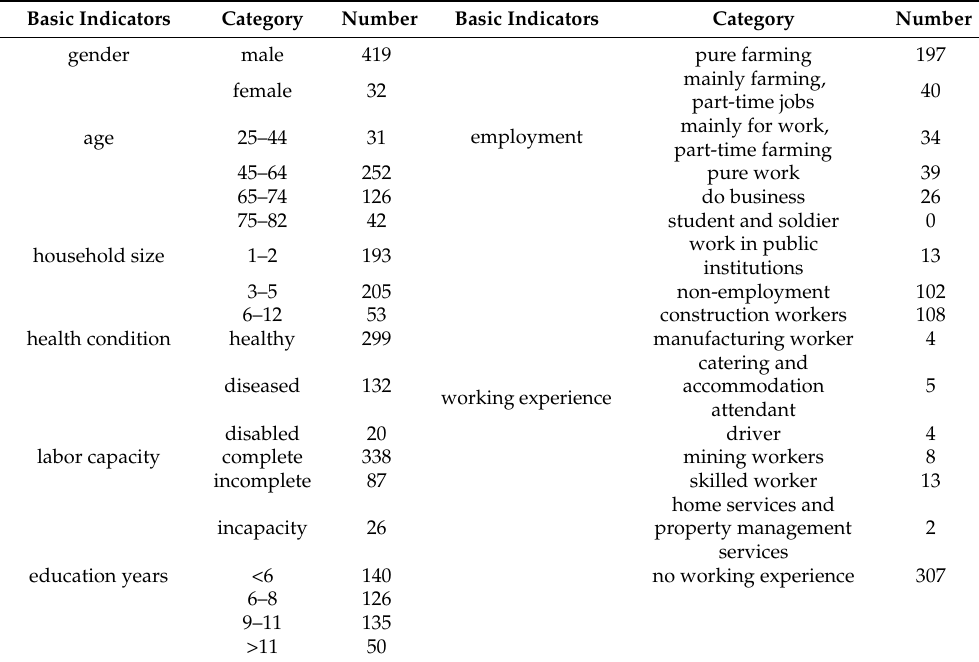
Table A1. The basic information of householders about the 451 surveyed households in 2017.